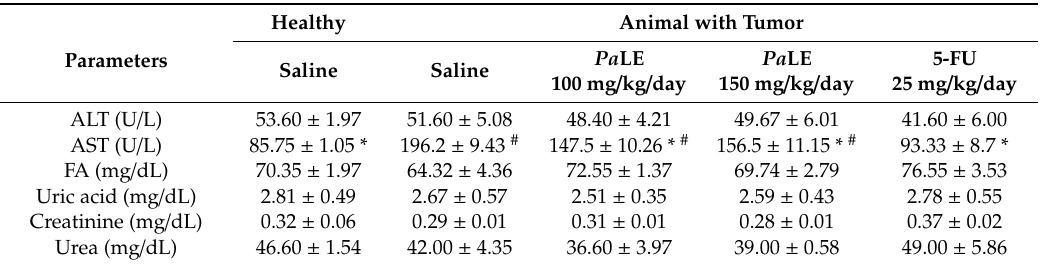
Table 4. E ff ect of Pa LE (i.p.) on the hepatic and renal biochemical parameters of the blood of mice with and without S180